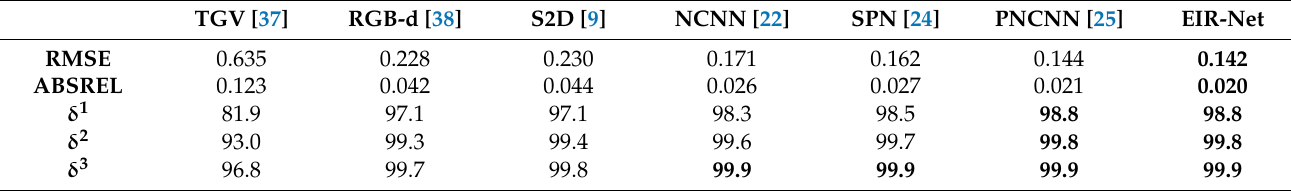
Table 2. Comparisons to other methods on NYU. The bold numbers are the